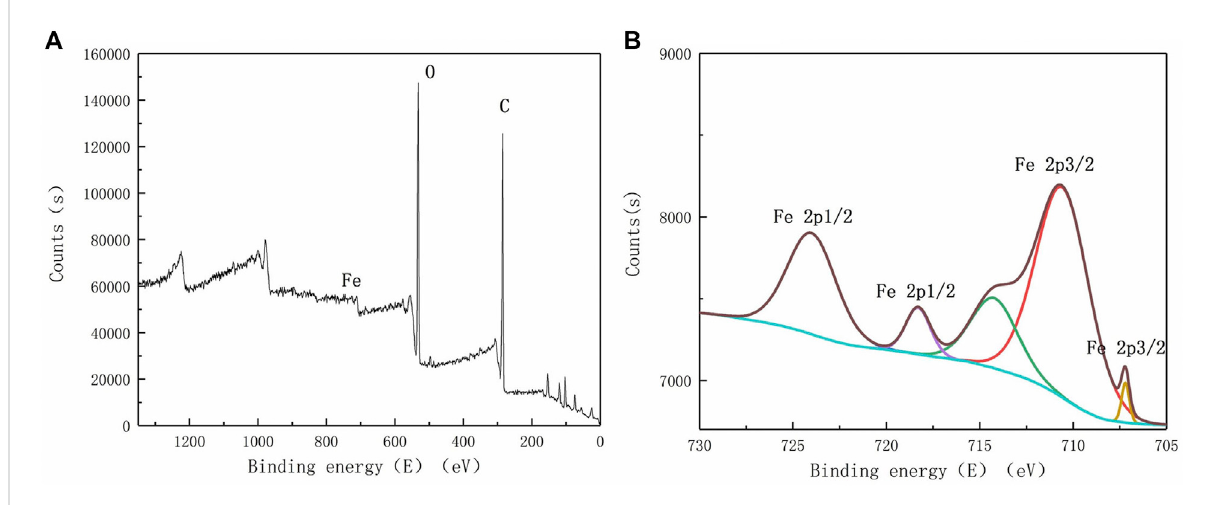
FIGURE 8 X-ray photoelectron spectroscopy before phosphorus adsorption (A) complete spectrum; (B) enlarged spectrum of